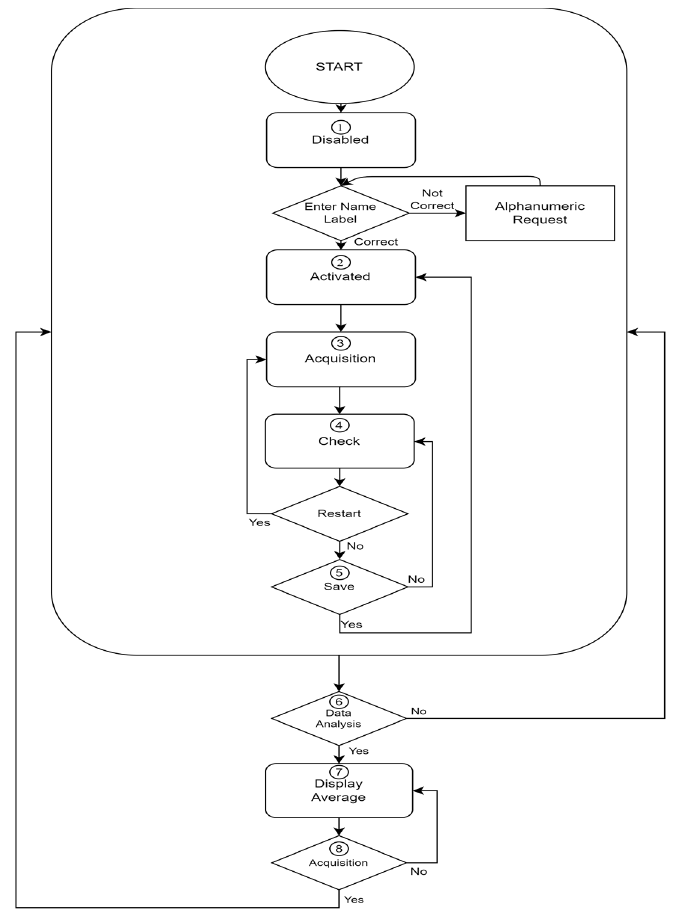
Figure 4. Operator interface flow chart.